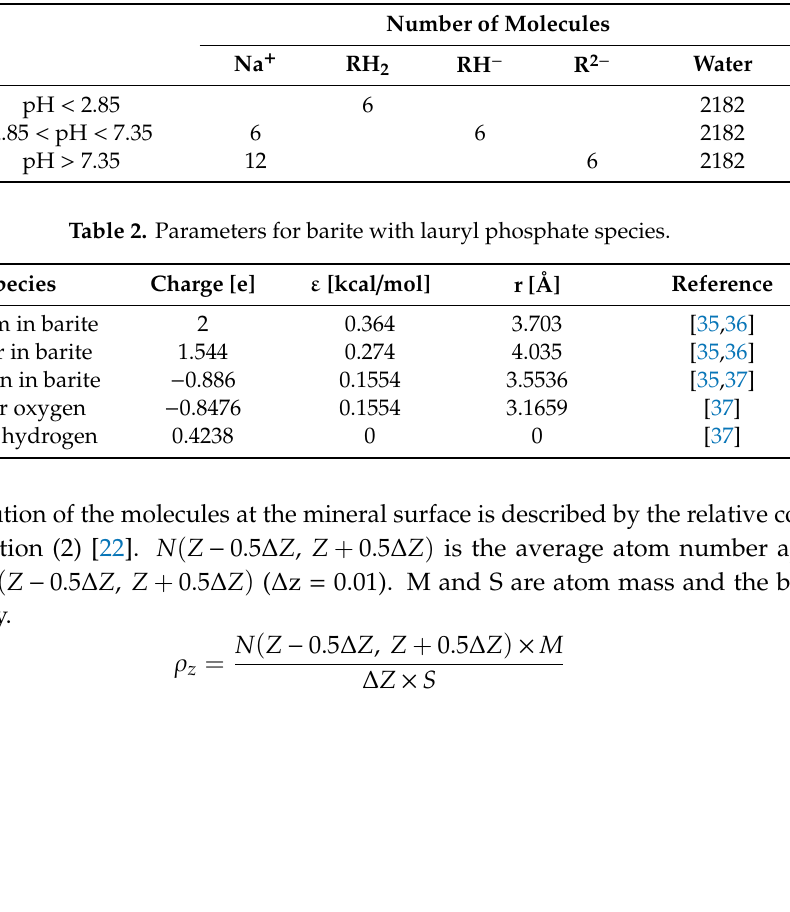
Table 1. The composition and molecule number on the barite surface with lauryl phosphate species.